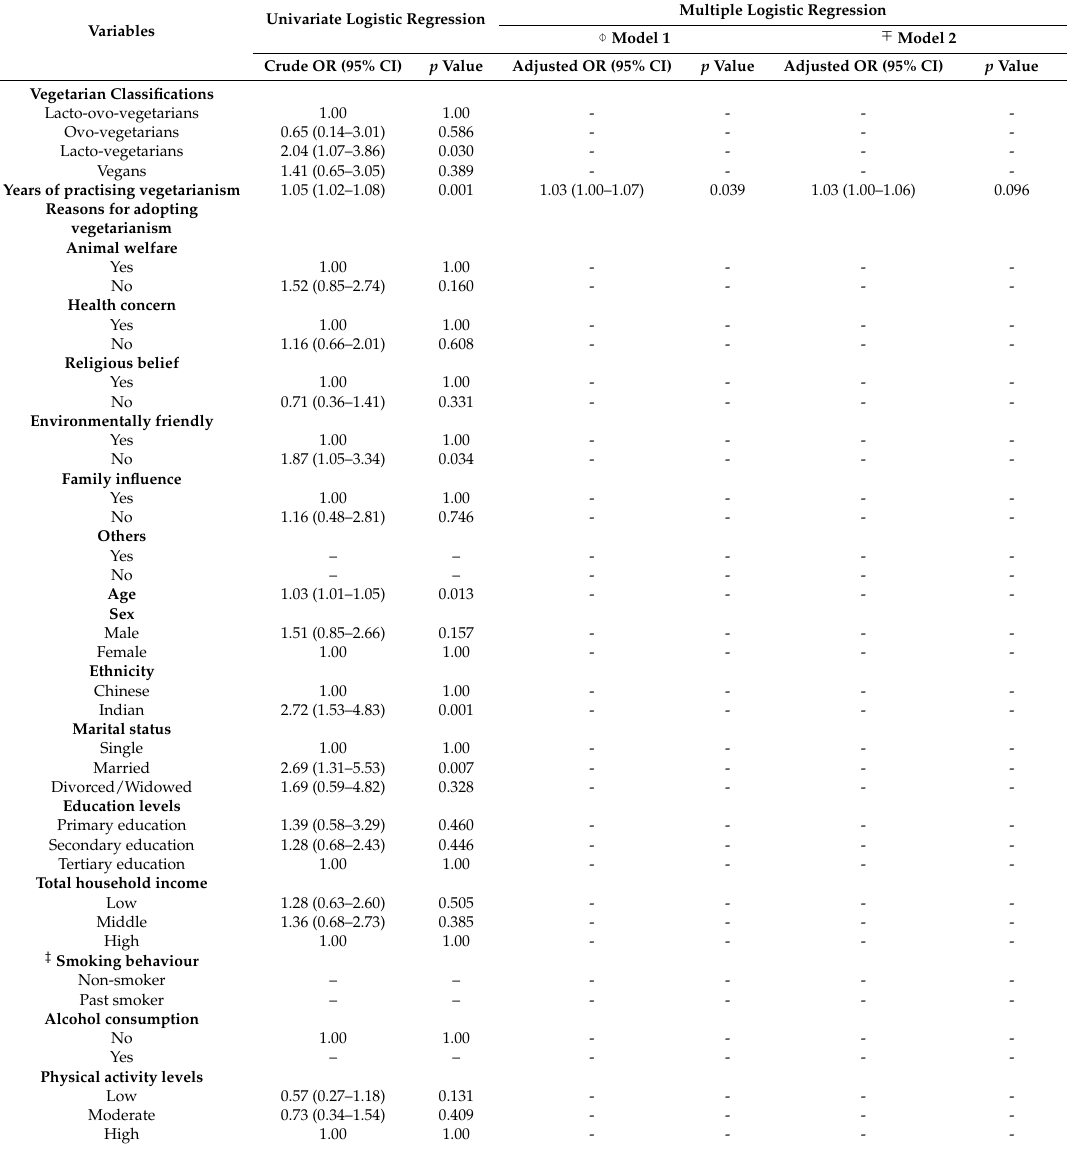
Table 2. Metabolic risks profile of vegetarians by sex.